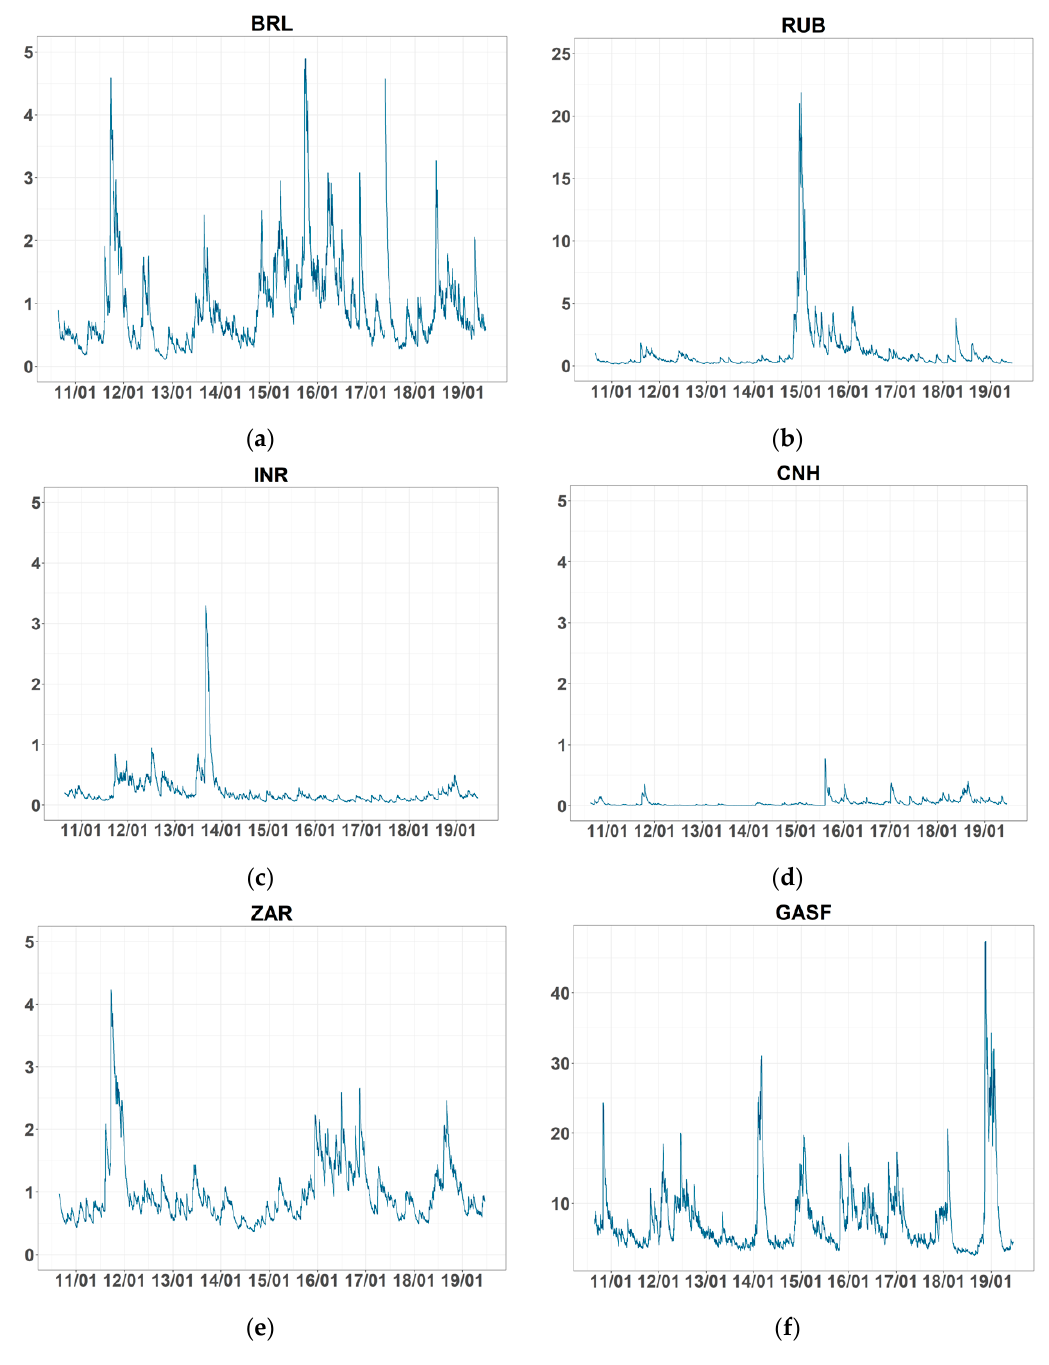
Figure 2. Volatility. Note: BRL, RUB, INR, CNH, and ZAR are Brazilian Real, Russian Ruble, Indian Rupee, offshore Chinese Yuan, and South African Rand, respectively. GASF is the Henry Hub natural gas futures price. ( a – f ) refer to the volatility of BRL, RUB, INR, CNH, ZAR, and GASF return series, respectively. Table 3. Summary statistics for volatilities of daily returns.